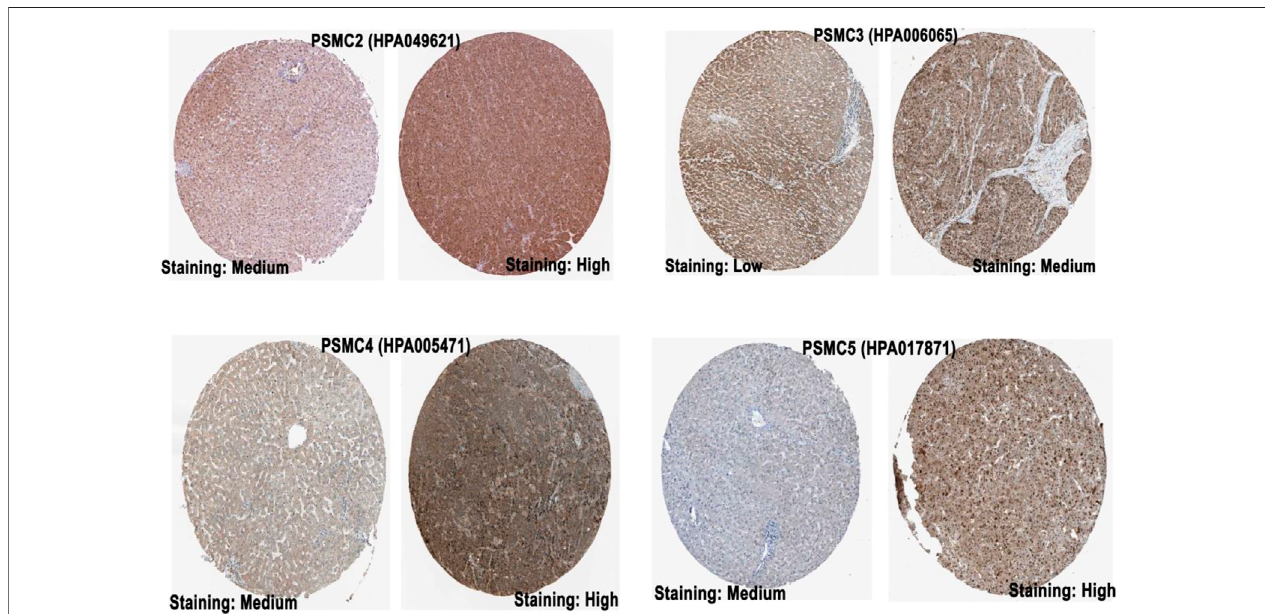
FIGURE 3 | IHC images (visualized at 200 µm) delineating the protein level expression of PSMC s in normal lung (left) and LUAD tissue (right) from the HPA server. The name of the corresponding antibody used for IHC staining has been indicated inside the parentheses in addition to the gene name. The representative image for PSMC1 was not found (Source: The Human Protein Atlas; https://www.proteinatlas.org/).